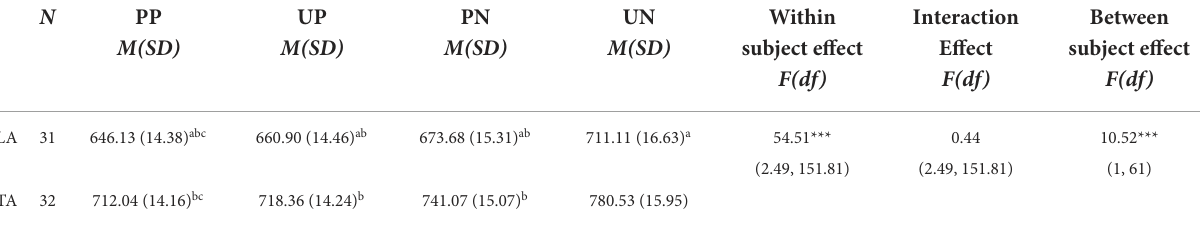
TABLE 3 Means ( M ), Standard Deviations ( SD ) and the results of rmANOVA for RT. N